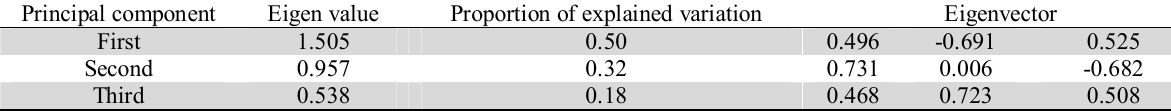
Results of PCA of normalized SS for the responses (case study 2) Principal component Eigen value Proportion of explained variation First